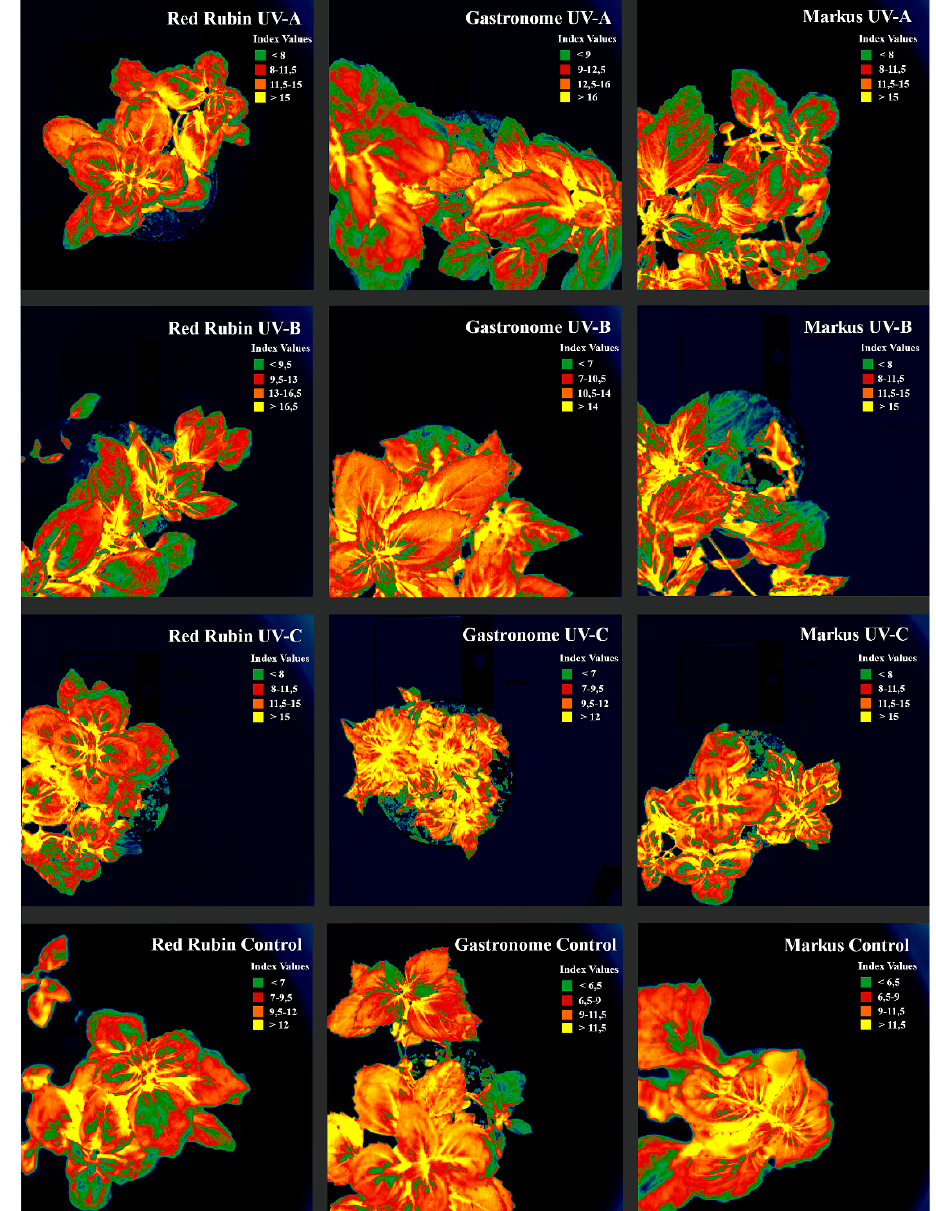
Figure 6. Graphic image of mARI index of basil leaves in false colors on 30th day of cultivation. The analysis revealed the uneven distribution of the indices of R 750 /R 700 for chloro- phylls and mARI for anthocyanins over the leaf area (Figures 6 and 7). Similar results were obtained for other indices under study (the data are not provided). This can be attributed to the varietal characteristics of the purple basil, which, depending on a variety, is char- acterized by instability of the purple pigments (anthocyanins) in both individual leaves and the whole plant [33]. Additionally, the uneven distribution of the index is affected by shadows due to uneven lighting and the glare of reflected light from the glossy surface of the leaf. To process the obtained hyperspectral images, the software “Envi 5.2” was used, the vegetative indices average values were obtained for whole plants on the 30th day of cultivation. For analyzing, from images of individual leaves, several areas were selected not containing any glare and shadows; then the average index value for the selected areas was determined (Table